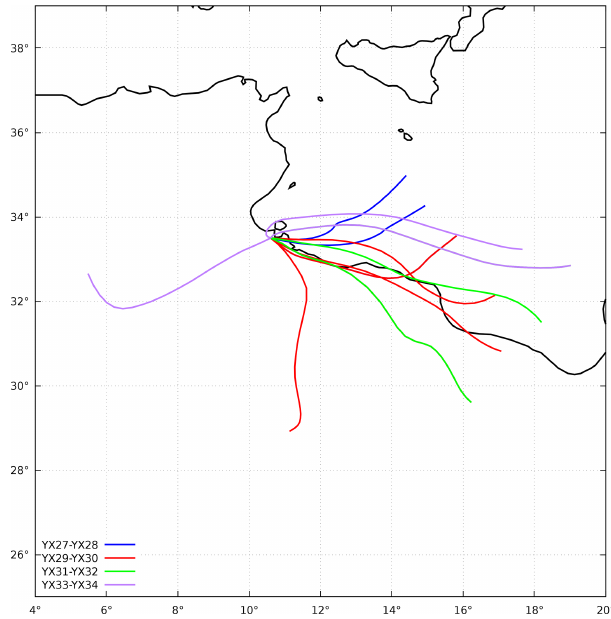
Figure C5. Backward trajectories of sample pairs YX27–YX28, YX29–YX30, YX31–YX32, and YX33–YX34. The x axis is longi- tude, and the y axis is latitude. Two or three trajectories are associ- ated with a given sample pair of ≈ 12h duration, except for the pair YX29–YX30, for which four trajectories are necessary because the sampling duration was 24h.